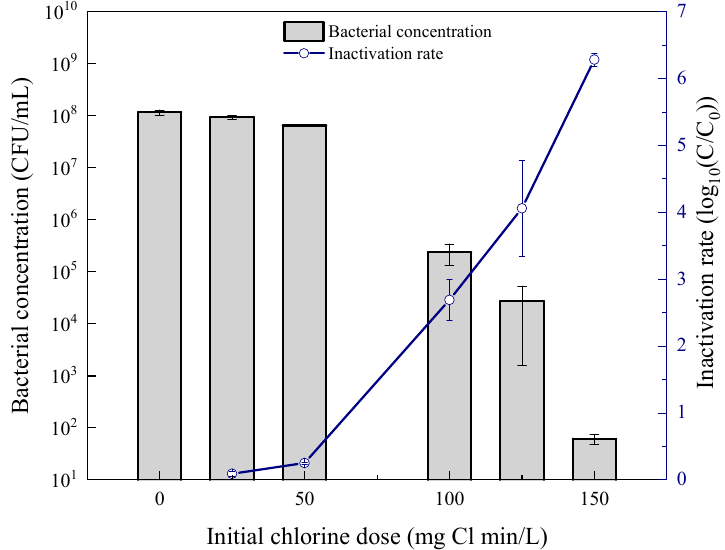
Figure 1. The inactivation rates and bacterial survival counts with the different initial concentrations of chlorine. Temperature = 25 °C; inactivation time = 15 min; the error lines represent the standard deviation of 3 replicate experiments.